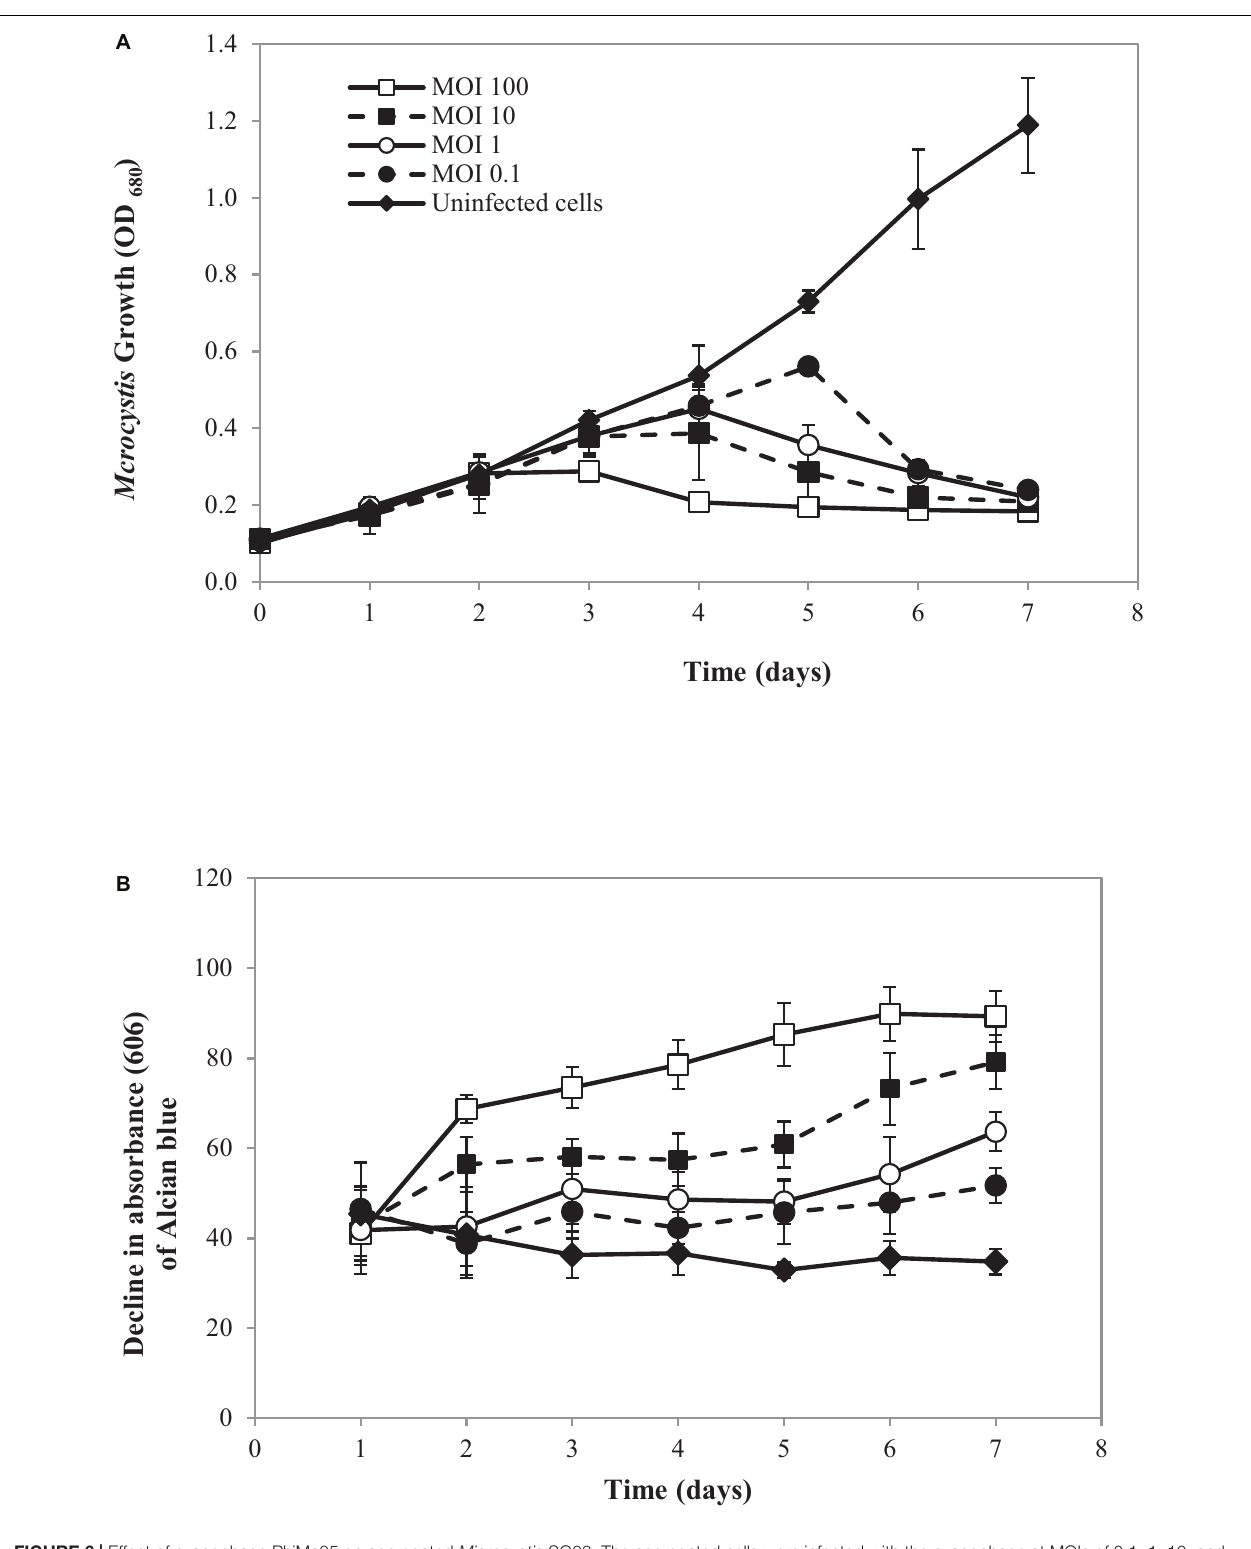
FIGURE 6 | Effect of cyanophage PhiMa05 on aggregated Microcystis SG03. The aggregated cells were infected with the cyanophage at MOIs of 0.1, 1, 10, and 100. (A) Time-kill assay of cyanophage PhiMa05 against aggregated Microcystis SG03. (B) Effect of phage on bacterial aggregation. The data show the means ± standard deviations based on triplicated